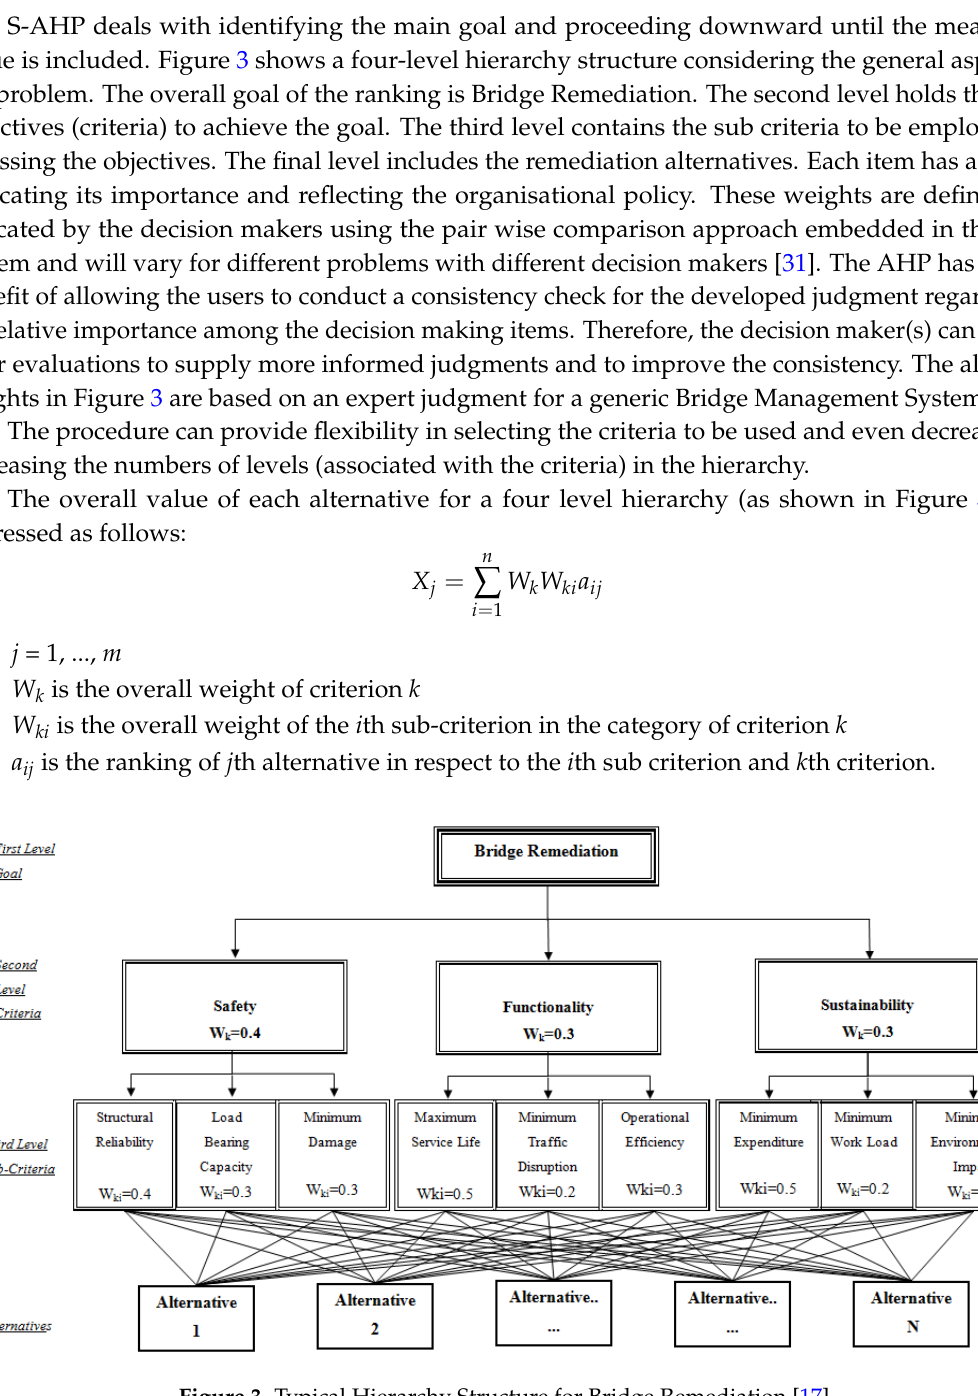
Figure 3. Typical Hierarchy Structure for Bridge Remediation [17].